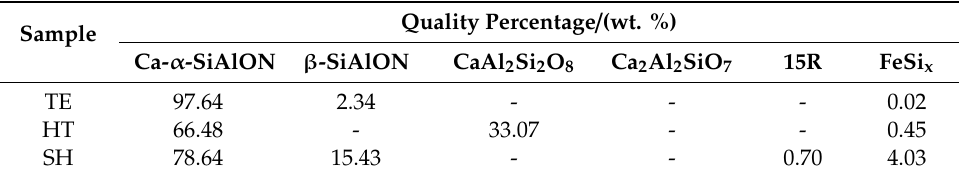
Table 4. The result of quantitative phase analysis at 1450 °C for 4 h.